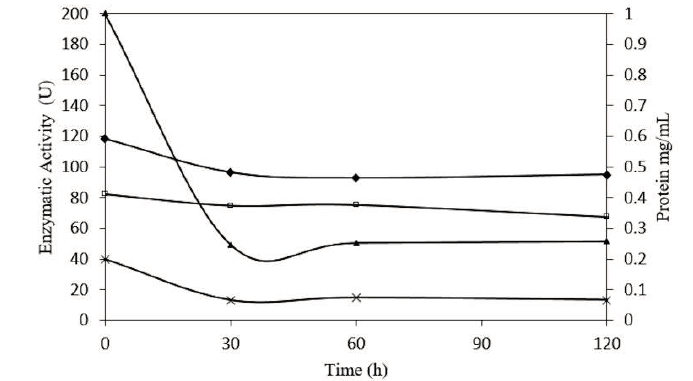
Figure 12. Concentration-dependent stability of β -glucosidase from Sechium edule at 45 °C, in pH 5.